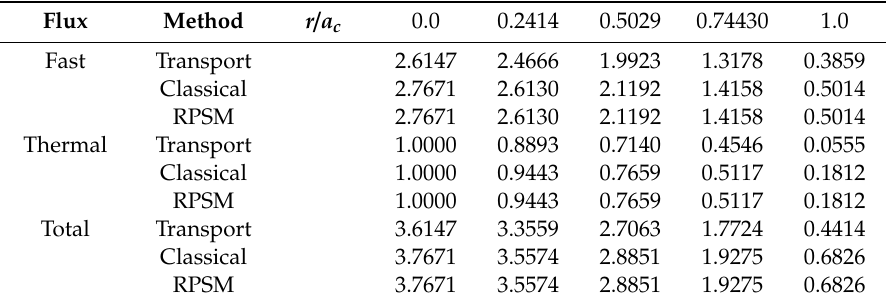
Table 8. The normalized thermal, fast and total fluxes values across a slab geometry.